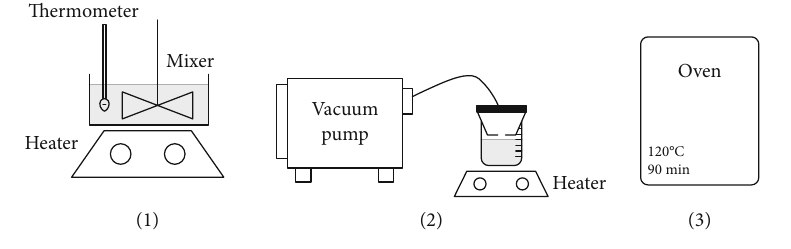
Figure 2: Details of the experimental setup. Table 3: Mechanical properties of di ff erent